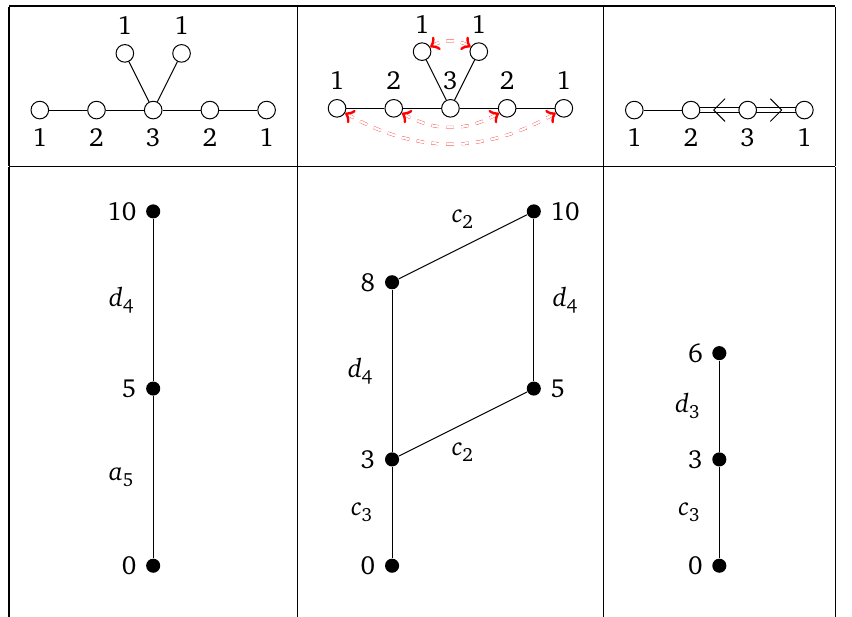
Table 5: Comparison of the Hasse diagrams for a quiver with a (cid:90) corresponding wreathed and folded